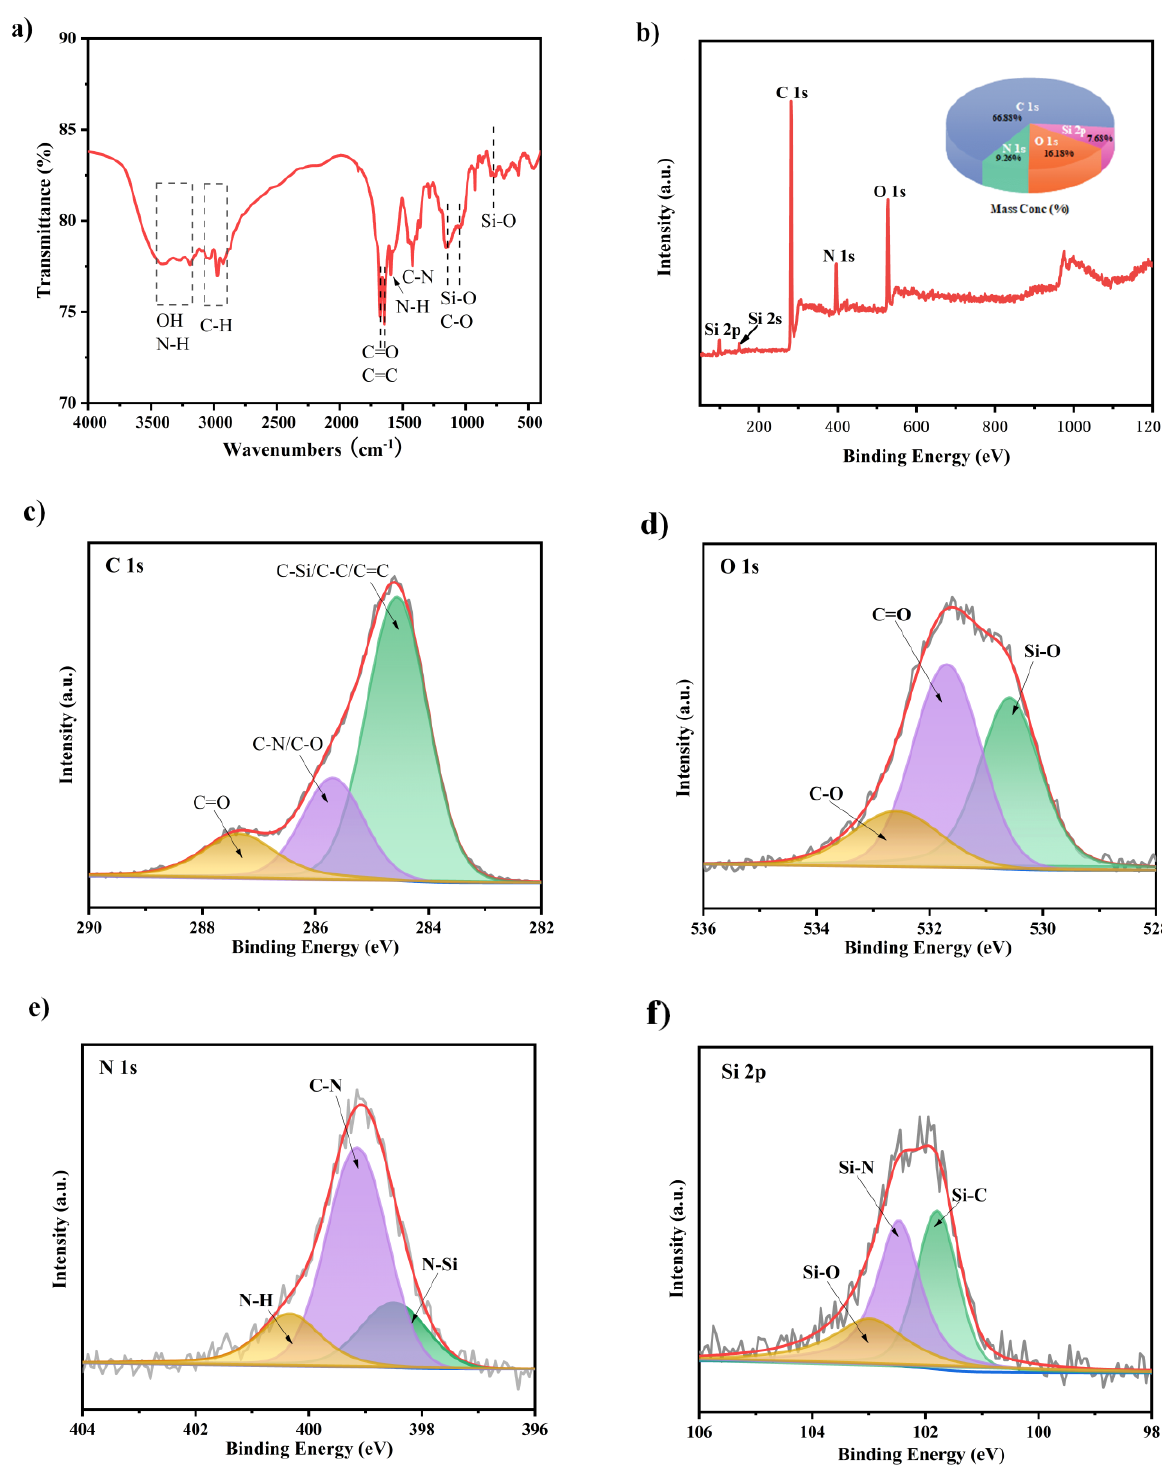
Figure 3. ( a ) FTIR spectrum of Si,N-CQDs. ( b ) XPS spectrum of Si,N-CQDs and high-resolution XPS C1s, O1s, N1s, and Si2p spectra ( c – f ).